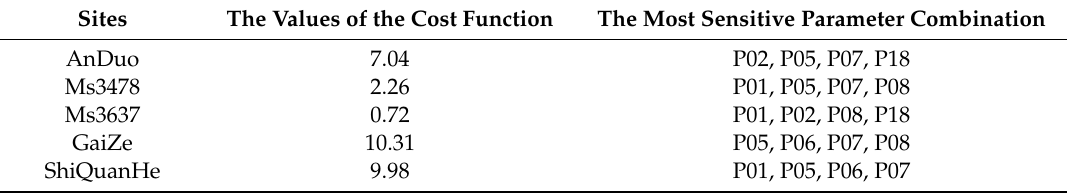
Table 5. The most sensitive parameter combinations for ST at di ff erent sites and their corresponding values of the cost